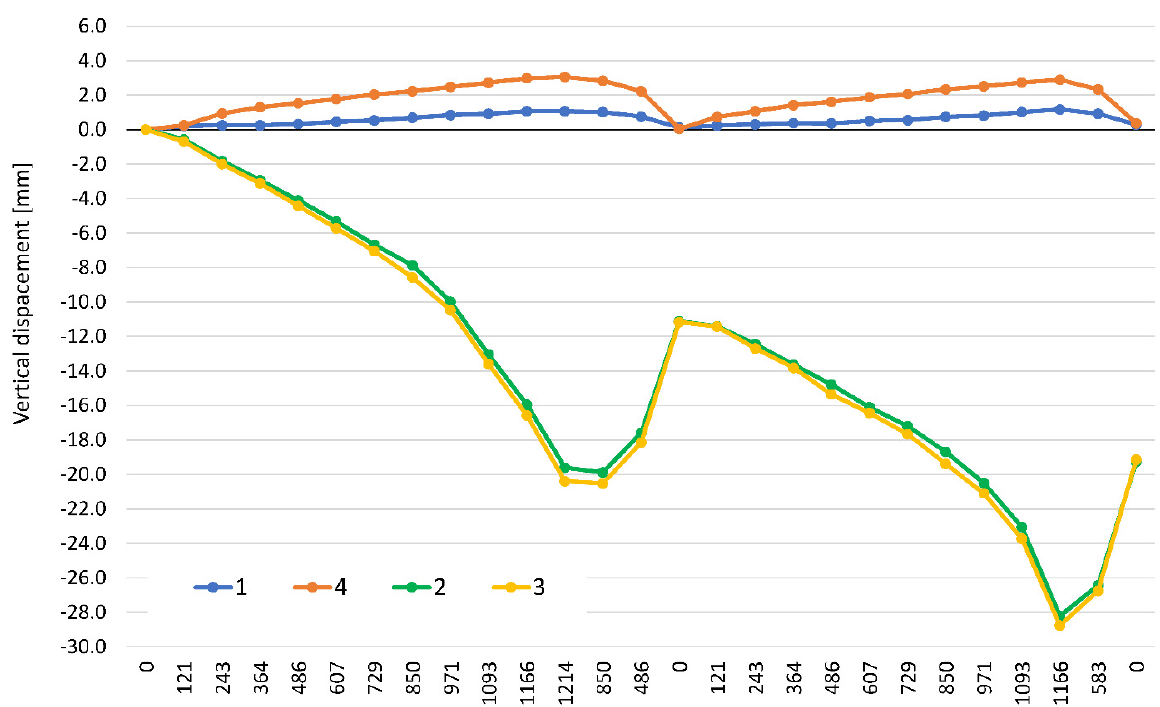
displacement determination for each reference point).